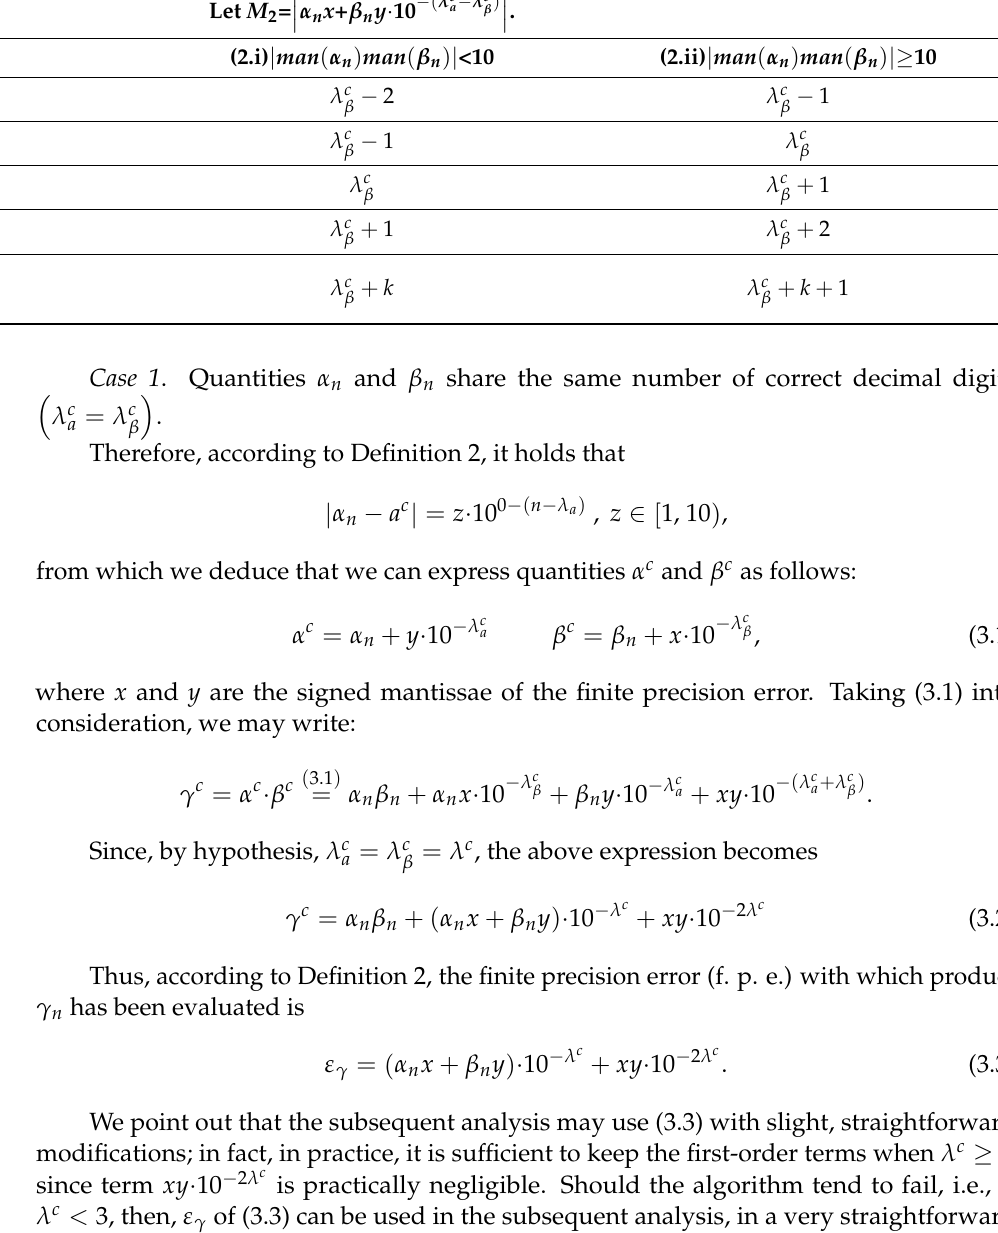
and in particular λ c α > λ c , without any loss of generality. The first column under β β (cid:12) (cid:12) (cid:12) (cid:12) + β n y · 10 − ( λ c a − λ c β ) (cid:12) α n x (cid:12) are shown. In Line 3, in the right of the same title,